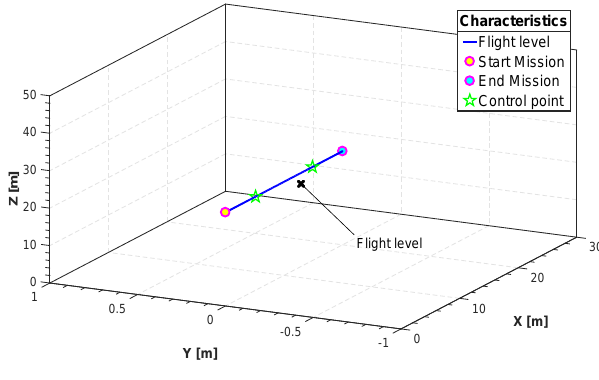
Figure 6. Three-dimensional flight level (FL)